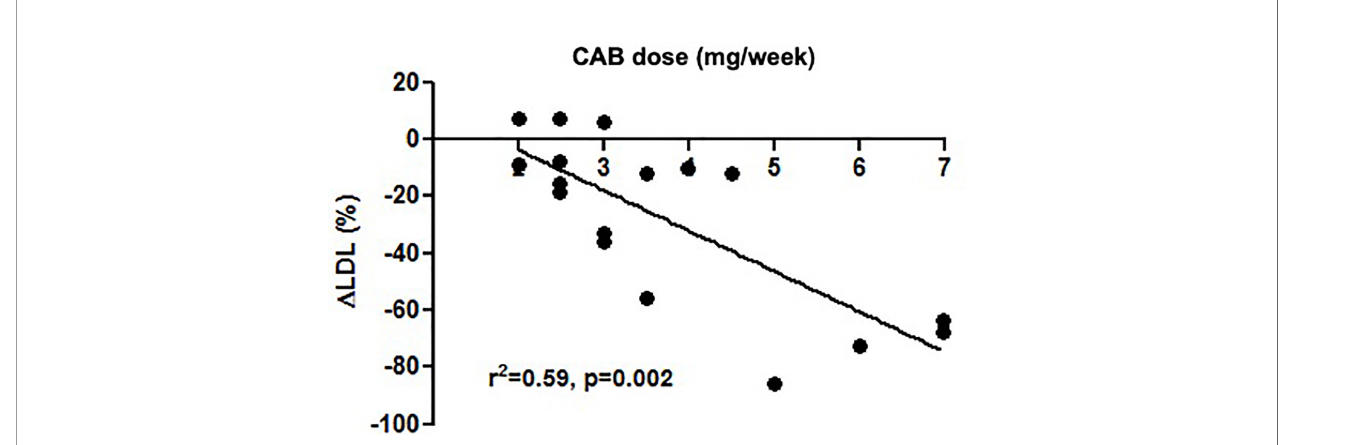
FIGURE 1 | CAB dose was the best predictor of percent change ( D %LDL) in Group